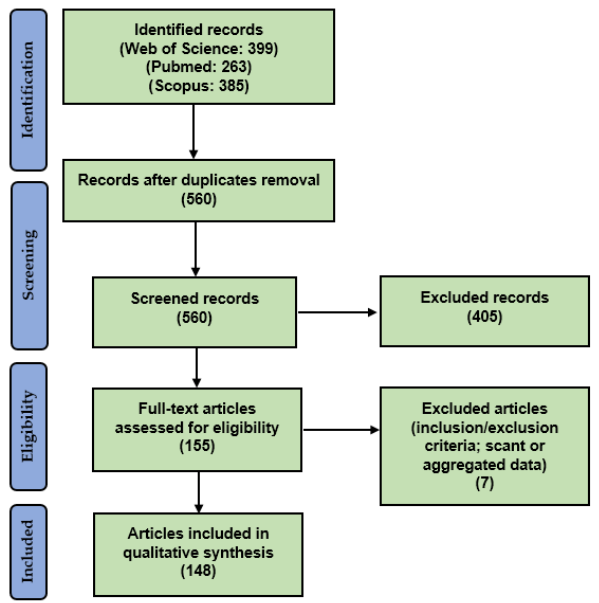
Figure 1. PRISMA flowchart of the systematic literature review.